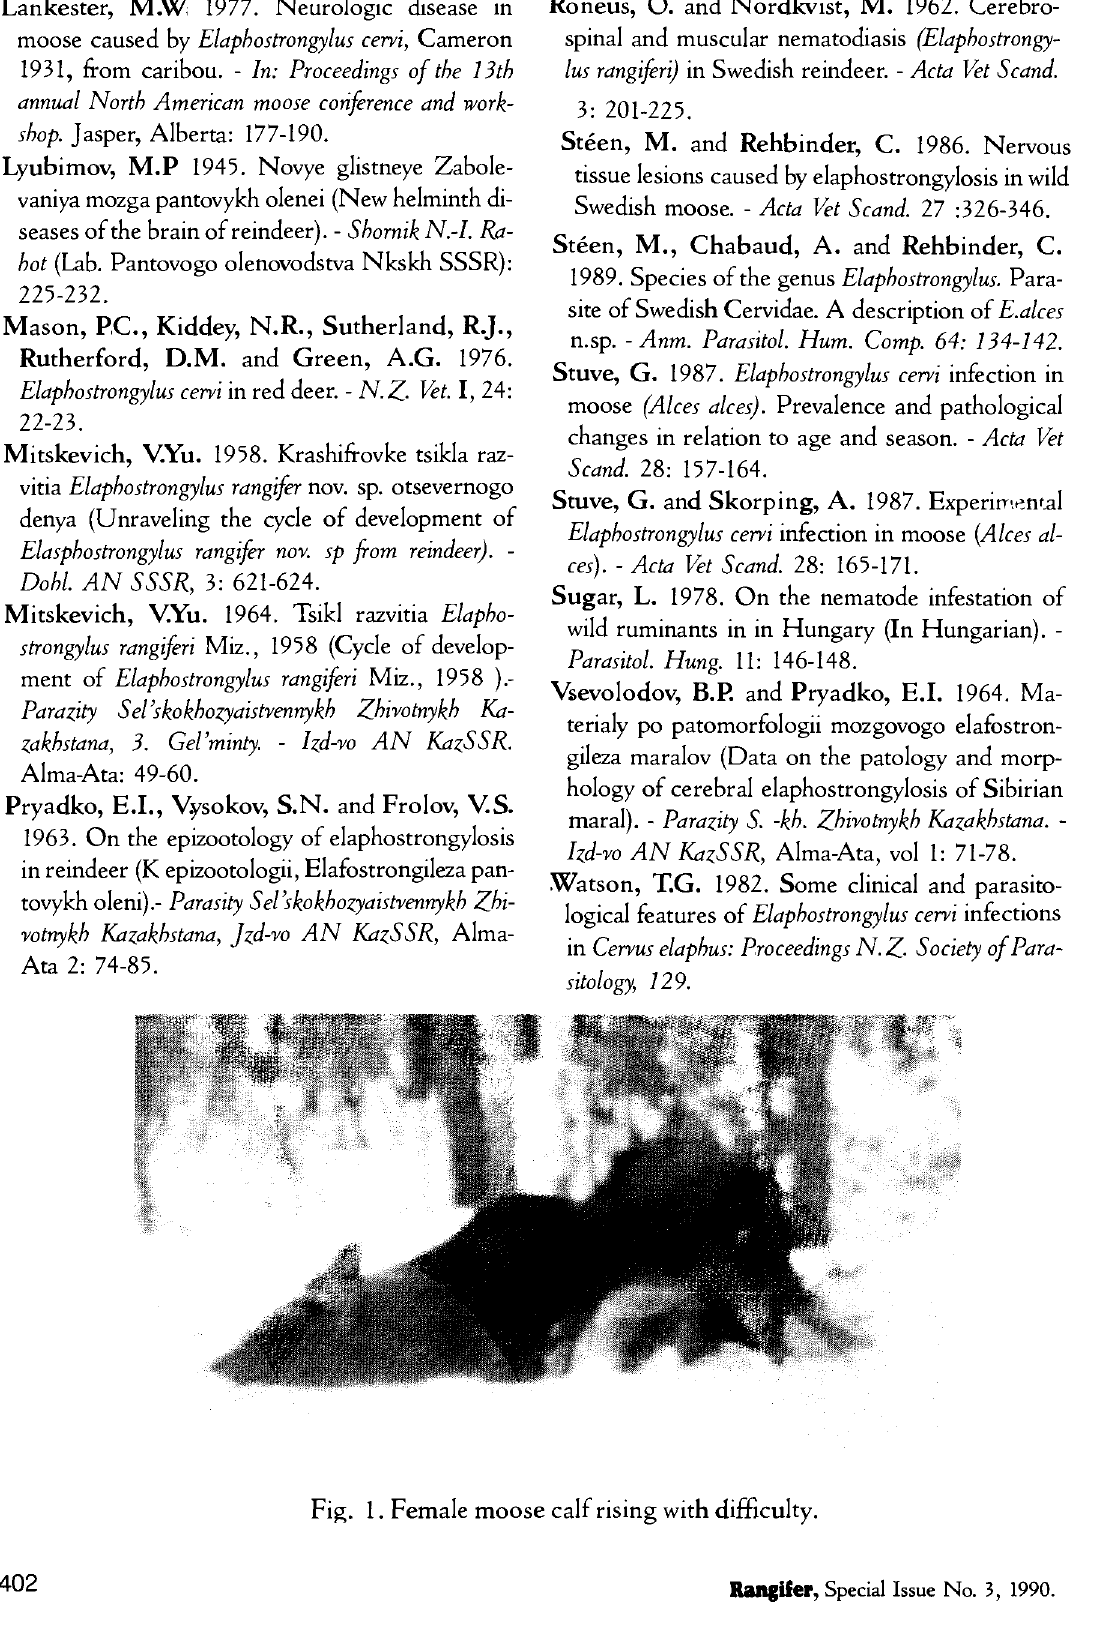
Fig. 1. Female moose calf rising with